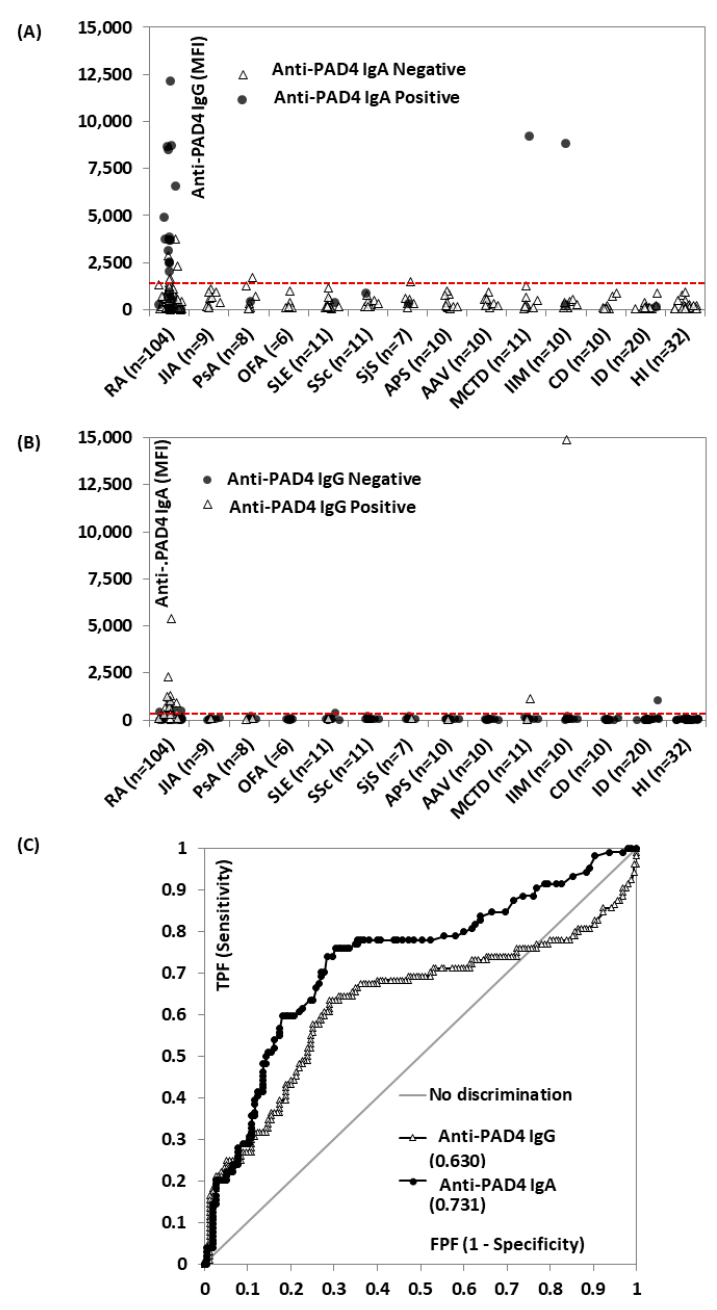
Figure 1. Anti-protein-arginine deiminase (PAD) 4 IgG and IgA in rheumatoid arthritis (RA) patients and controls ( N = 259). Levels of anti-PAD 4 IgG ( A ) and IgA ( B ) in the different disease groups are shown, labeled by positivity on the other isotype. The red dashed line represents the cut-offs. The receiver operating curve (ROC) analysis of anti-PAD 4 IgG (grey) and IgA (black) for the discrimination of RA patients vs. controls is illustrated in ( C ). The area under the curve (AUC) is shown for each isotype. Abbreviations: AAV: antineutrophil cytoplasmic antibody (ANCA)-associated vasculitis; APS: antiphospholipid syndrome; AUC: area under the curve; CD: celiac disease; HI: healthy individuals; IIM: idiopathic inflammatory myopathies; ID: infections disease; JIA: juvenile idiopathic arthritis; MCTD: mixed connective tissue disease; MFI: median fluorescent intensity; OFA: other forms of arthritis; PAD: protein-arginine deiminase; PsA: psoriatic arthritis; RA: rheumatoid arthritis; ROC: receiver operating characteristic; SjS: Sjogren’s syndrome; SLE: systemic lupus erythematosus; SSc: systemic sclerosis; FPF: false positive fraction; TPF: true positive fraction.